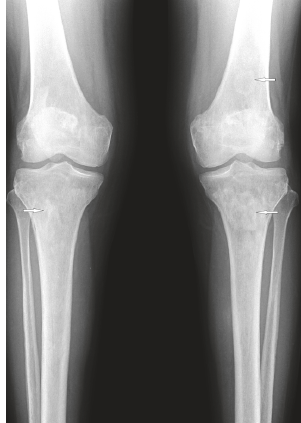
Figure 1: X-ray of both knees in anteroposterior view showing bilat- eral patchy high density donating sclerosis affecting the metaphysis of the distal femur and the proximal tibia bilaterally.